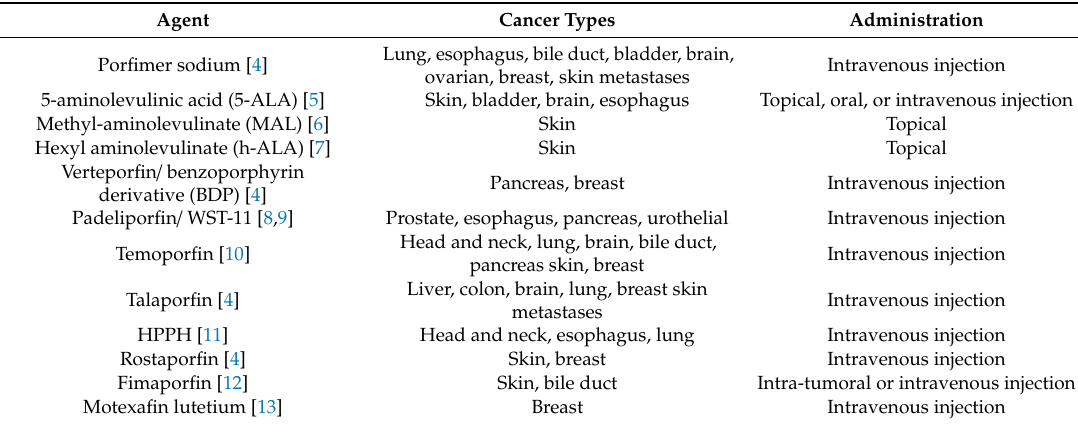
Table 1. Photosensitizers that have been approved or are under investigation for cancer